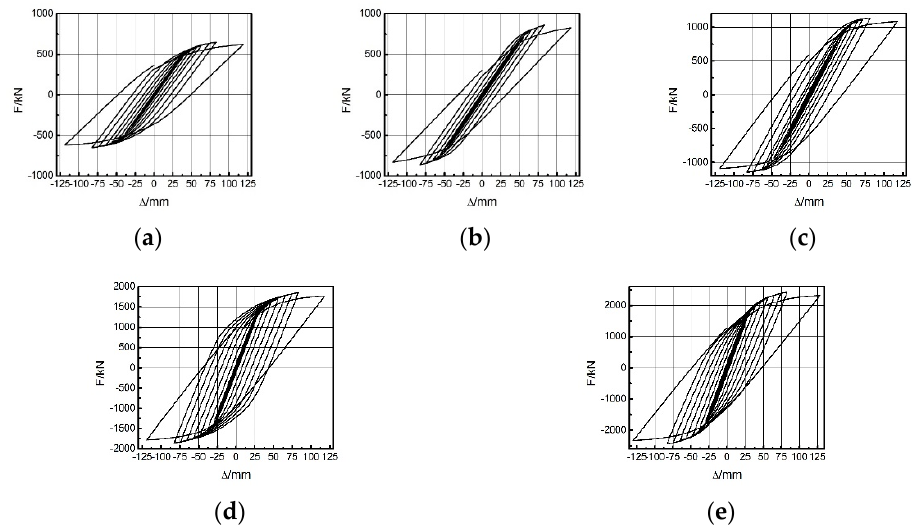
Figure 18. Stress contour plots of the EDCWs. ( a ) F11; ( b ) F12; ( c ) F13; ( d ) F14; and ( e ) F15.